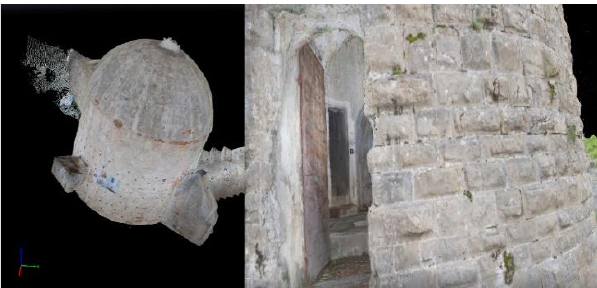
Figures 15: Result of 3D reconstruction for the outside of the dome.